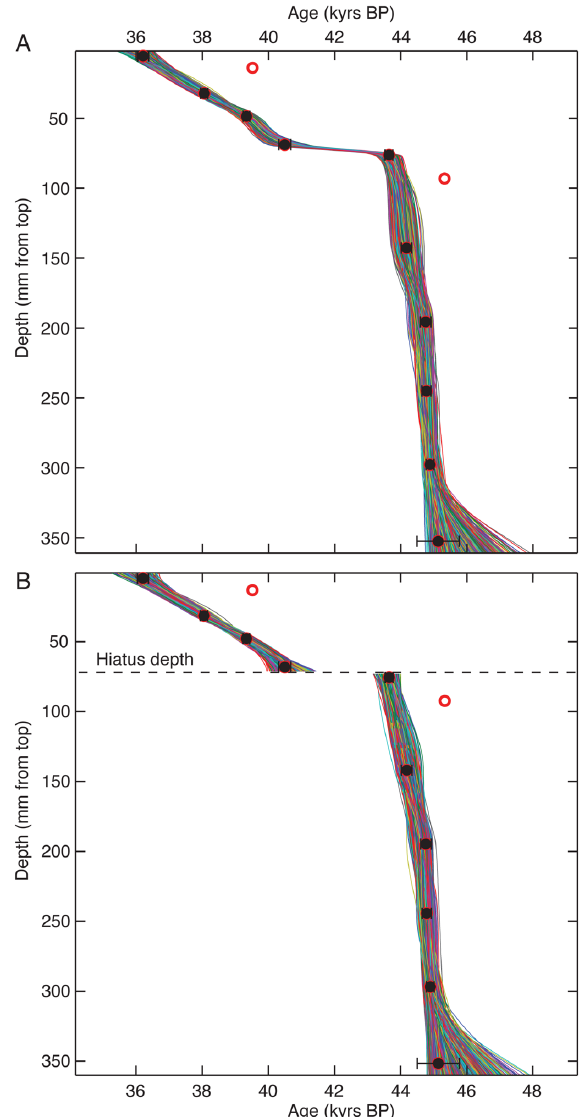
Fig. 8. Depth-age relationships in TSAL-1 with and without as- signed hiatus. The strong change in growth rate visible at 72.25mm in (A) is rather unrealistic. In plot (B) the known hiatus depth has been introduced and the realizations have been split in two seg- ments. The resulting depth-age relationships can now be used for the Monte Carlo simulations of the proxy